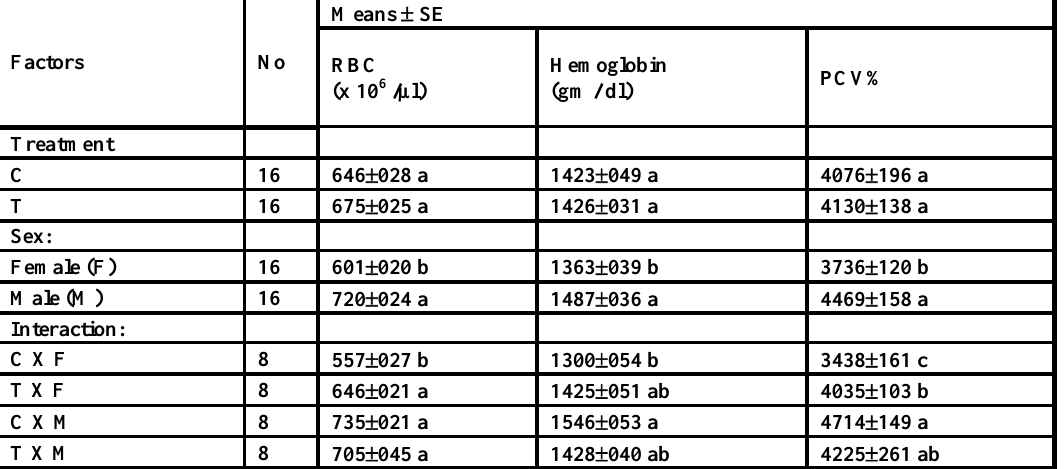
Table 1 Effects of Nigella sativa oil on RBC count hemoglobin and packed cell volume in male and female rats